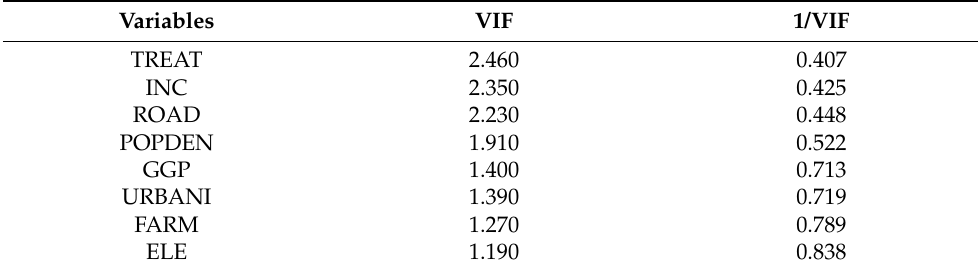
Table 3. Results of multicollinearity